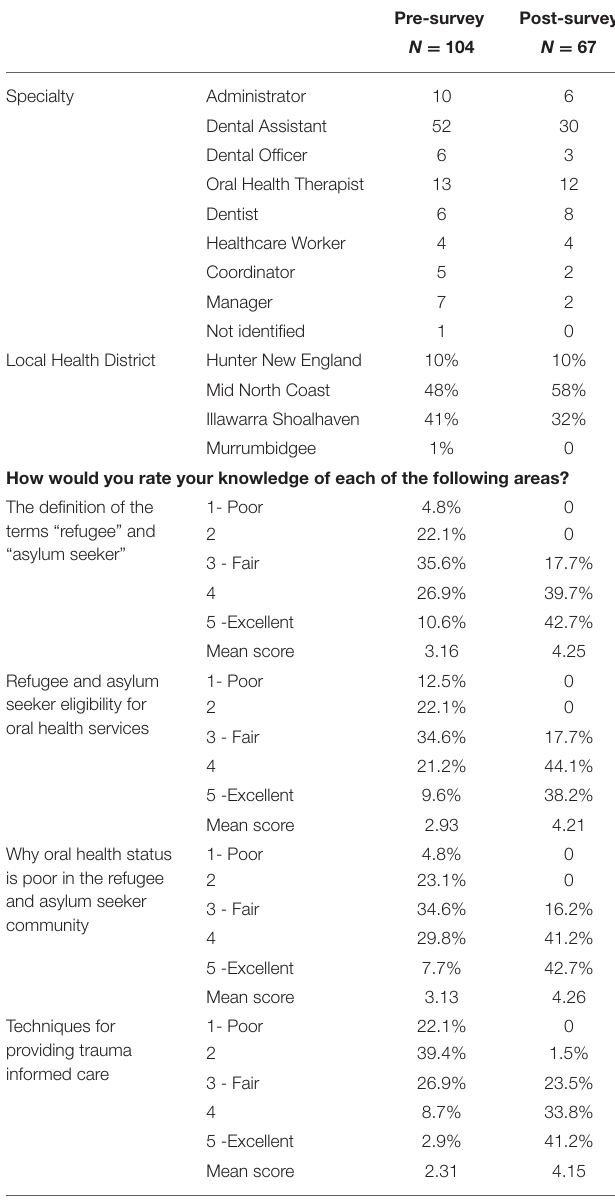
TABLE 1 | Demographic characteristics of pilot trauma informed care (TIC)